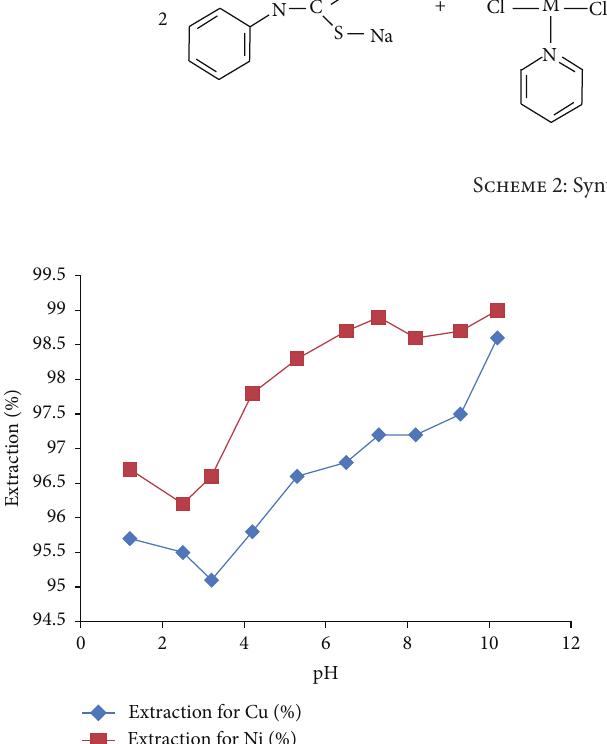
Figure 3: Graph of effect of pH on the extraction of copper ion or nickel ion extraction by N -methyl- N -phenyl dithiocarbamate.